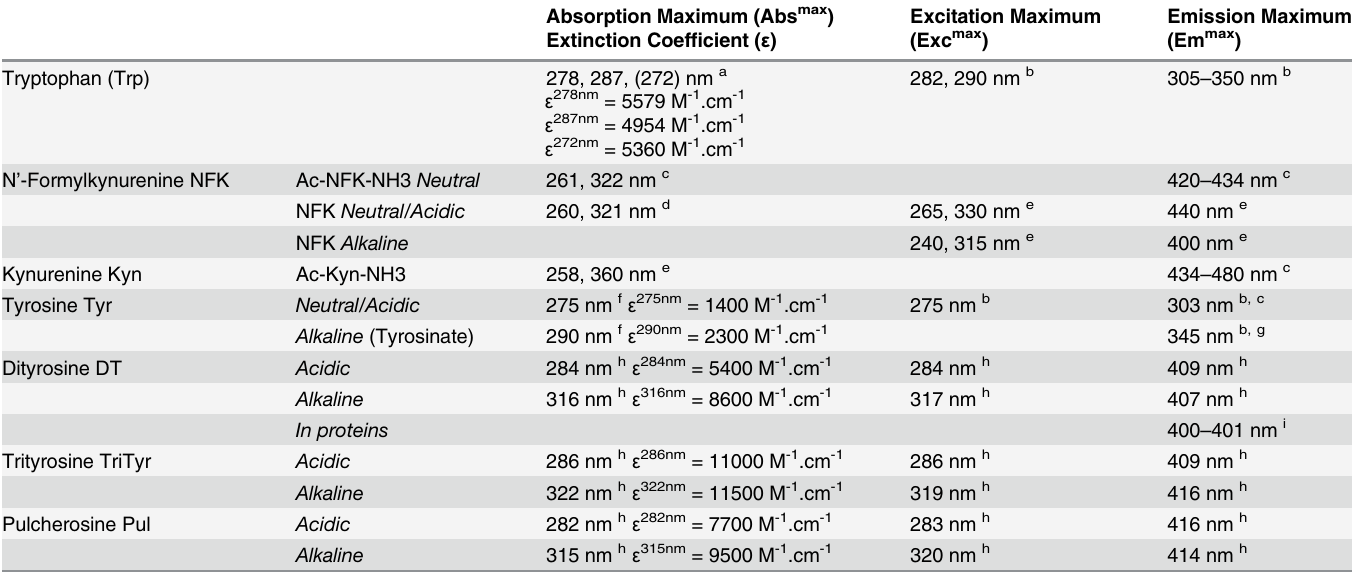
Table 1. Absorption and fl uorescence spectral characteristics of tryptophan, tyrosine and the major side-products formed upon their photo-